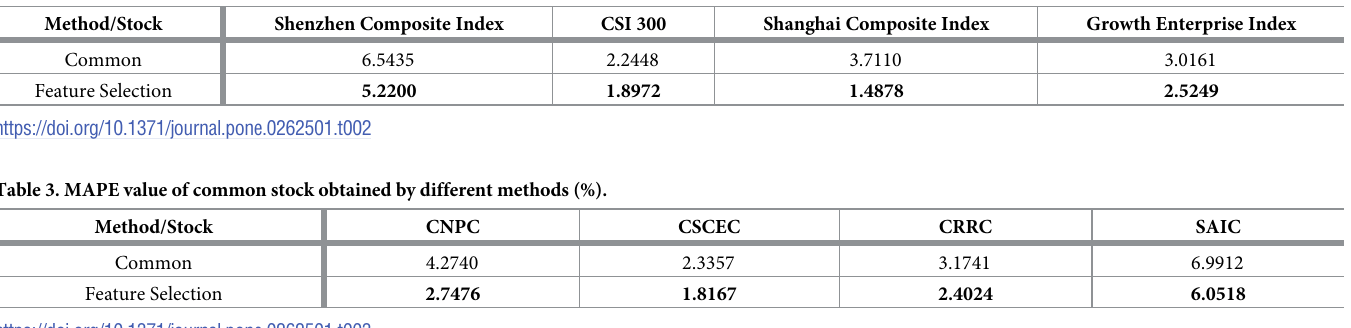
Table 2. MAPE value of index stock obtained by different methods (%).